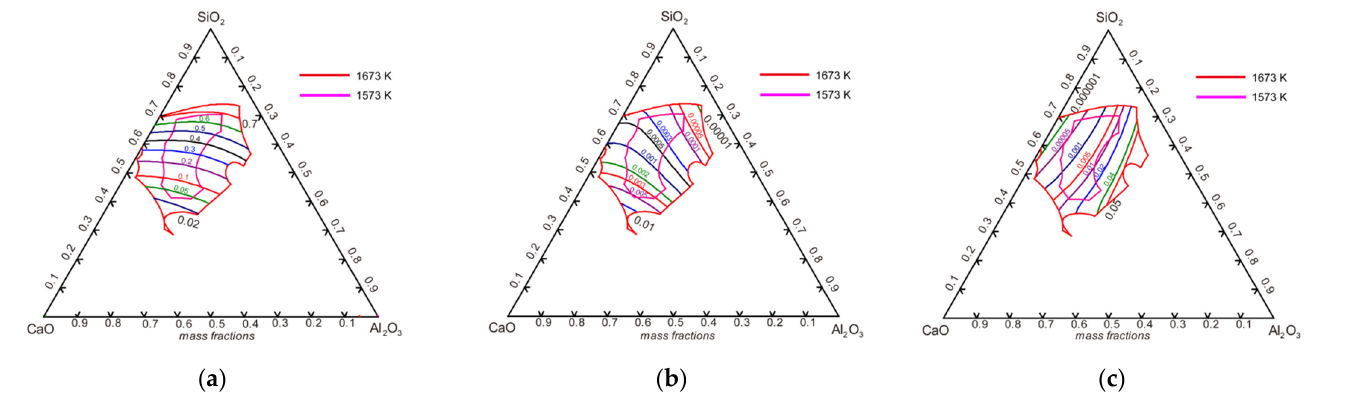
Figure 10. The isoactivity lines of SiO 2 , CaO and Al 2 O 3 at 1873 K: ( a ) SiO 2 ; ( b ) CaO; ( c ) Al 2 O 3 .